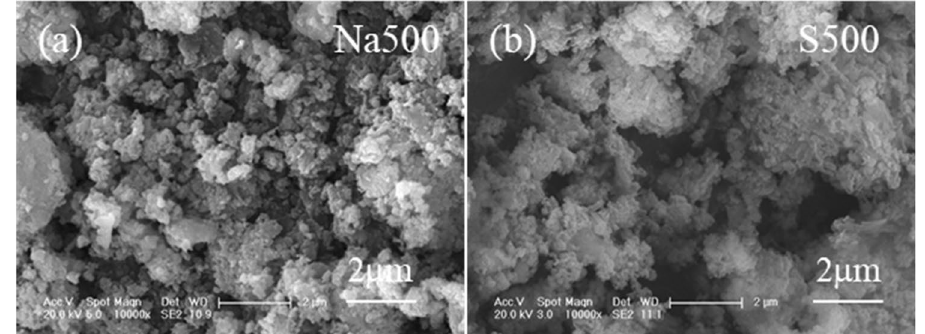
Figure 8. SEM pictures of ( a ) Na500 and ( b ) S500 after OTC